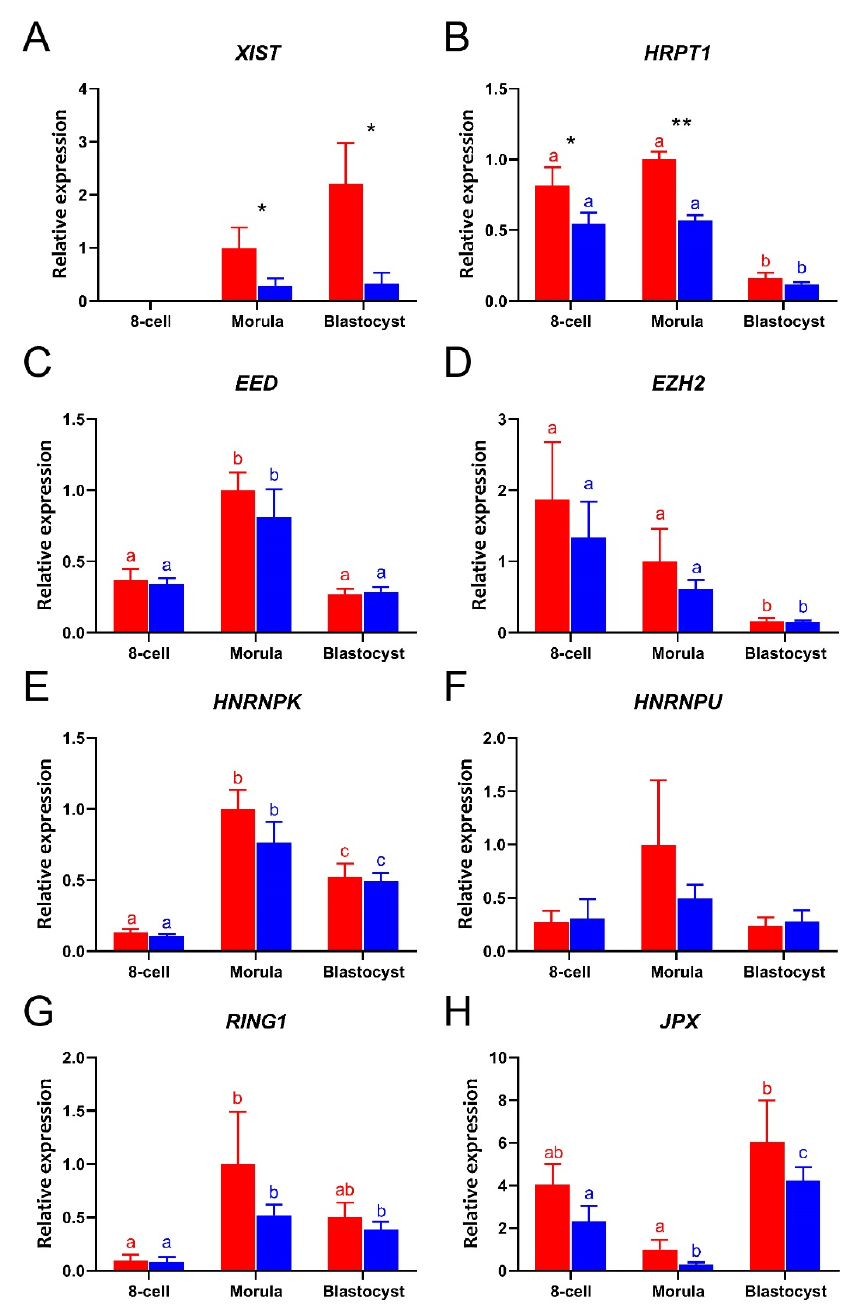
Figure 2. The relative expressions of XCI related genes in female (red bars) and male (blue bars) bovine embryos from 8-cell stage to day 8 blastocysts, as determined by quantitative RT-PCR. ( A ) XIST , ( B ) HPRT1 , ( C ) EED , ( D ) EZH2 , ( E ) HNRNPK , ( F ) HNRNPU , ( G ) RING1 , ( H ) JPX. Relative expression from female morulae set at 1; * ( p < 0.05) and ** ( p < 0.005) indicate significant di ff erences between females and males. Significant di ff erences among embryos with same gender are indicated by di ff erent letters with the same color ( p < 0.05). Error bars indicate standard deviations of three independent biological replicates.